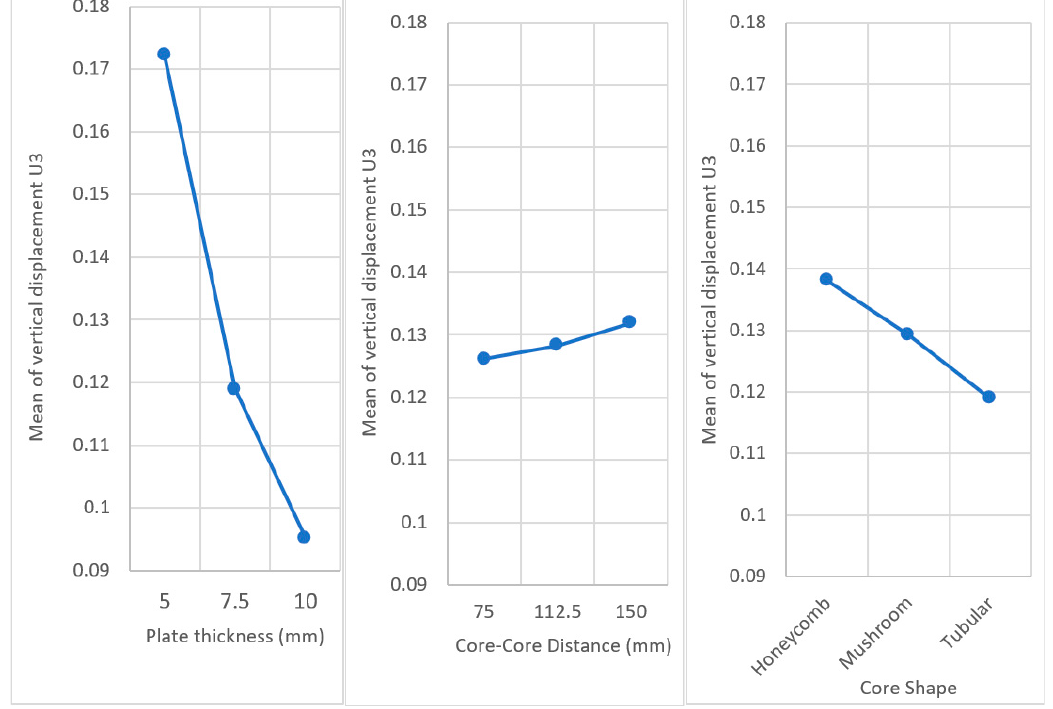
Figure 24. The simulation results of the mean of the sandwich panel displacement.